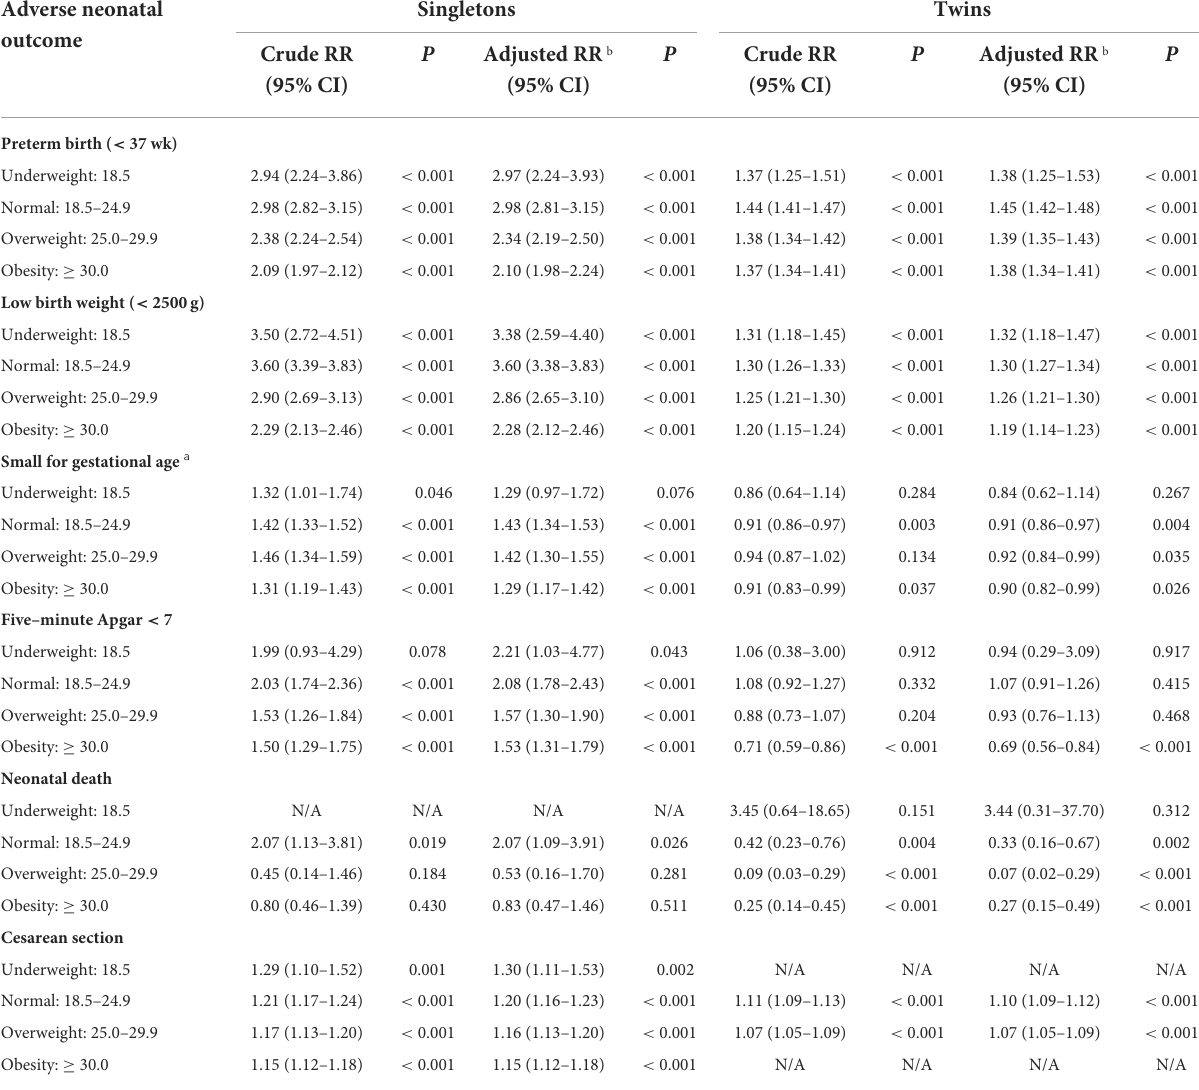
TABLE 4 Stratified analysis for the association of HDP and adverse neonatal outcomes in ART mothers by Prepregnancy BMI. Adverse